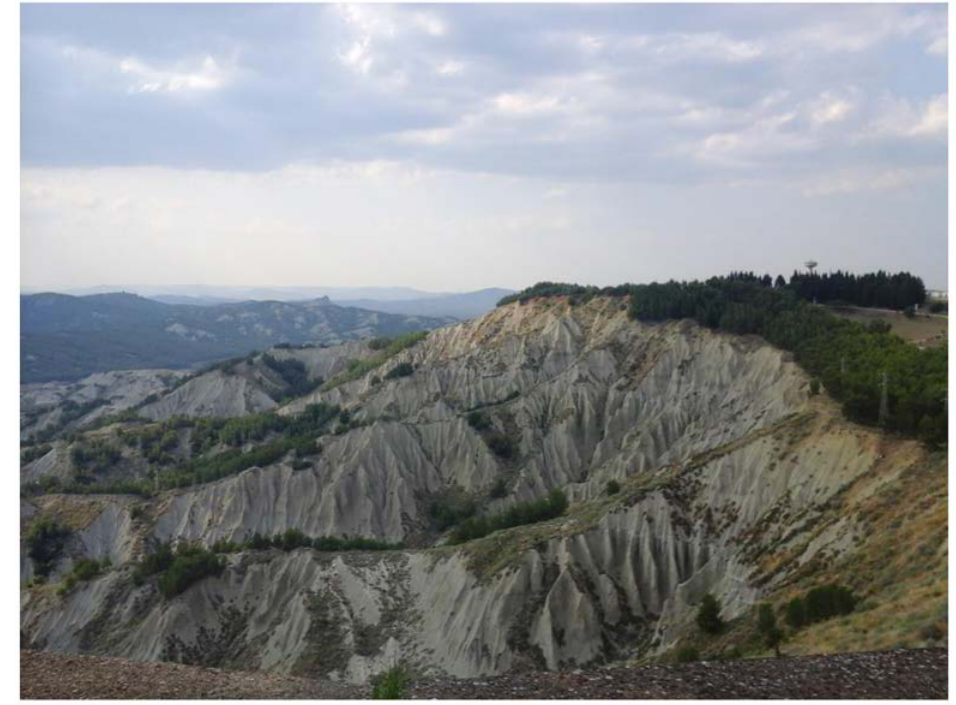
Figure 1. Calanchi in Montalbano Jonico, Basilicata,